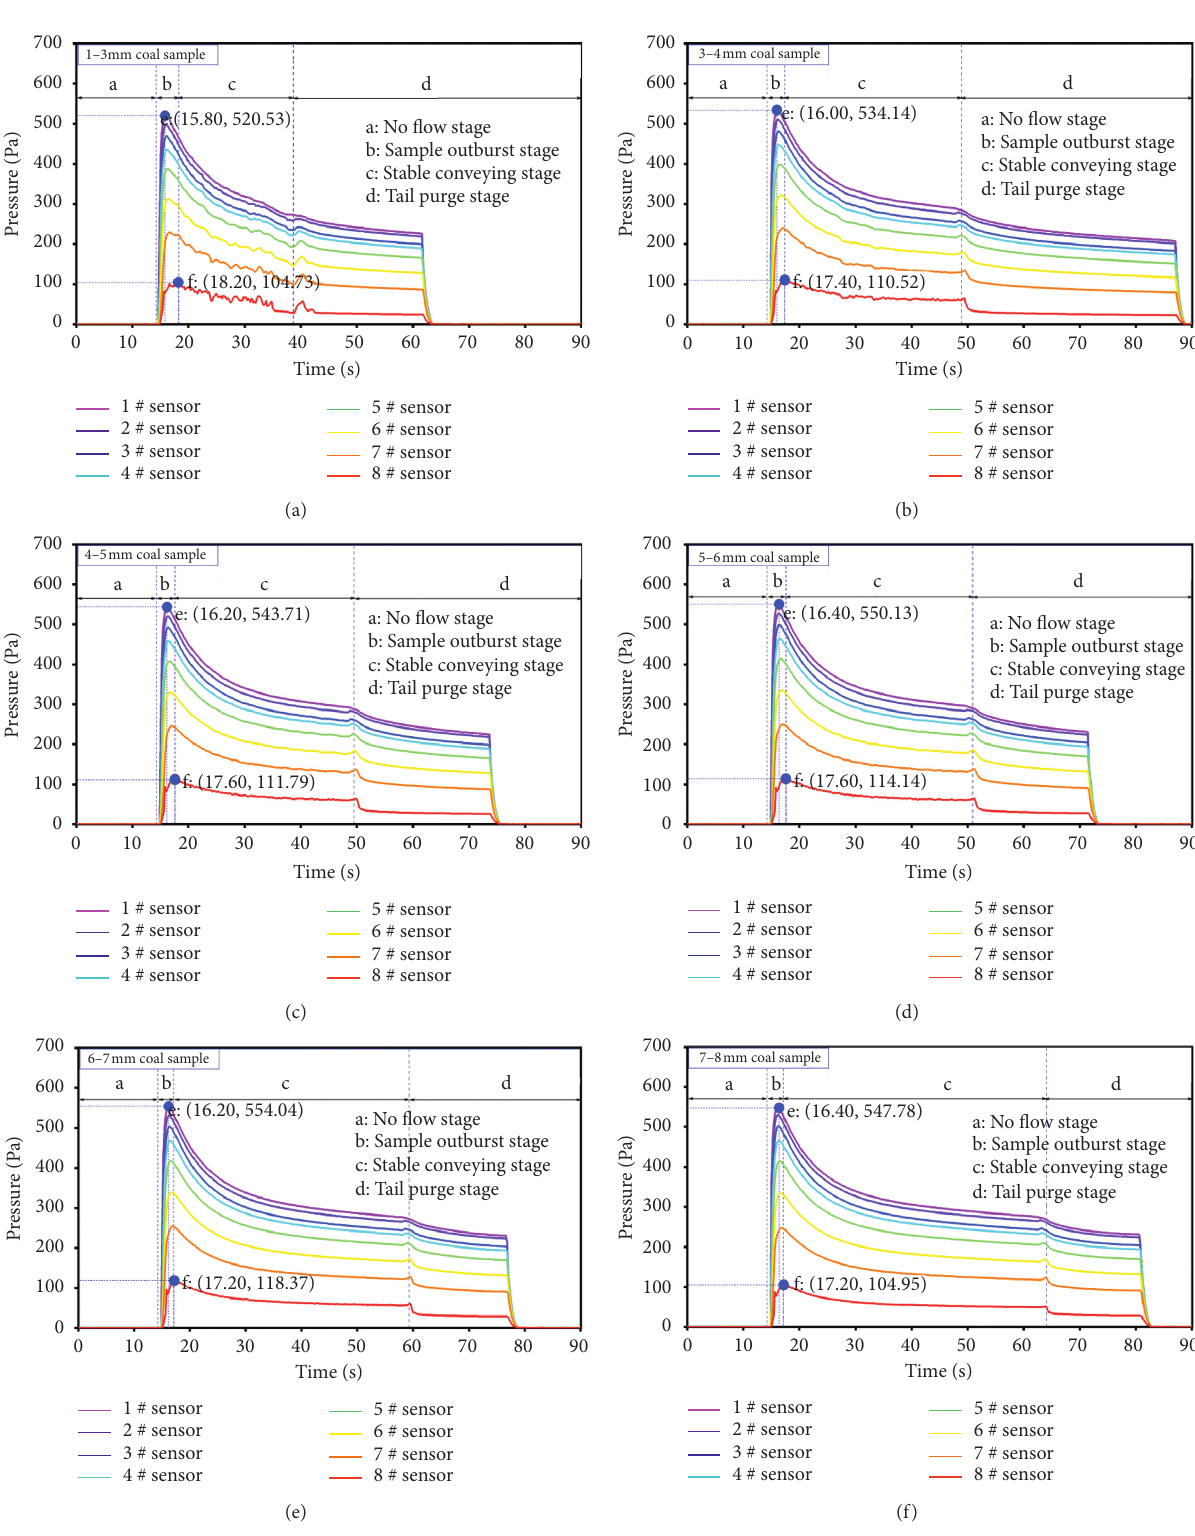
Figure 6: Pressure variation in the pipeline during the tests of single size coal sample. The point “e” represents the extreme pressure point of 1 # sensor, and the point “f” represents the extreme pressure point of 8 #